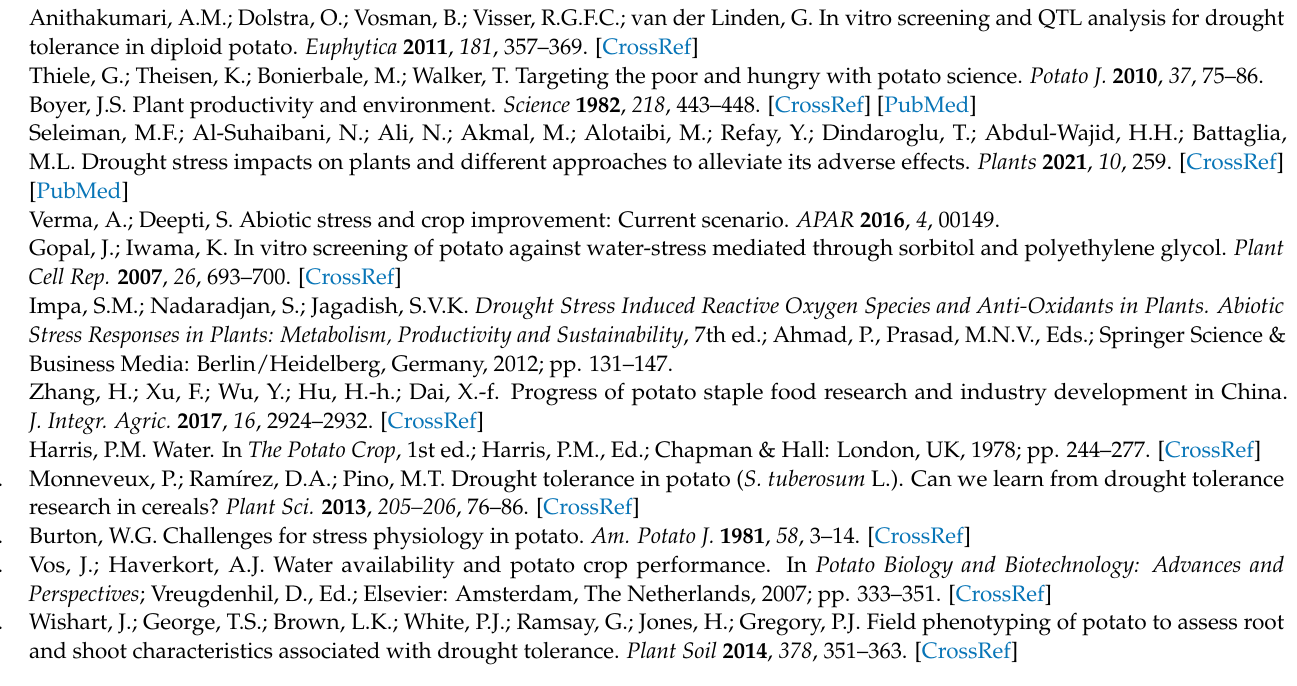
by PEG 600 added to the medium at levels of 2.5% (a), 5.0% (b) and 7.5% (c).; Figure S7: Root lengths SI (SI RL ) values of potato genotypes under osmotic stress induced by PEG 600 added to the medium at levels of 2.5% (a), 5.0% (b), 7.5% (c); Figure S8: Root number SI (SI RN ) values of potato genotypes under osmotic stress induced by PEG 600 added to the medium at levels of 2.5% (a), 5.0% (b), 7.5% (c); Figure S9: Survivor rate SI (SI SR ) values of potato genotypes under stress treatment induced by D-mannitol added to the medium at levels of 0.1 M (a), 0.2 M (b) and 0.3 M (c); Figure S10: Shoot length SI (SI SL ) values of potato genotypes under stress treatment induced by D-mannitol added to the medium at levels of 0.1 M (a), 0.2 M (b) and 0.3 M (c); Figure S11: Root length SI (SI RL ) values of potato genotypes under stress treatment induced by D-mannitol added to the medium at levels of 0.1 M (a), 0.2 M (b) and 0.3 M (c); Figure S12: Root number SI (SI RN ) values of potato genotypes under stress treatment induced by D-mannitol added to the medium at levels of 0.1 M (a), 0.2 M (b) and 0.3 M (c).; Table S1: Ranking of breeding lines cultured on medium supplemented with PEG 6000 including each SI value; Table S2: Ranking of breeding lines cultured on medium supplemented with PEG 600 including each SI value; Table S3: Ranking of breeding lines cultured on medium supplemented with D-mannitol including each SI value; Table S4: Ranking of breeding lines cultured on medium supplemented with PEG 6000, PEG 600 or D-mannitol including each SI value; Table S5: Osmolality values of MS media supplemented with different osmotic agents used in